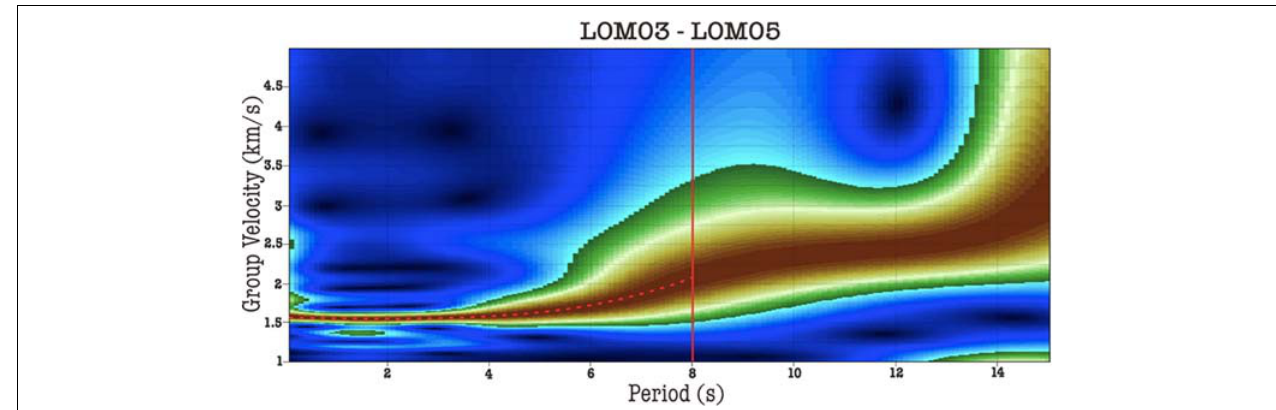
FIGURE 4 | Example of Time-Frequency Plot and Dispersion Analysis. The red line shows the SNR threshold. The Red dashed line shows the selected data. The brown area shows the maximum energy.